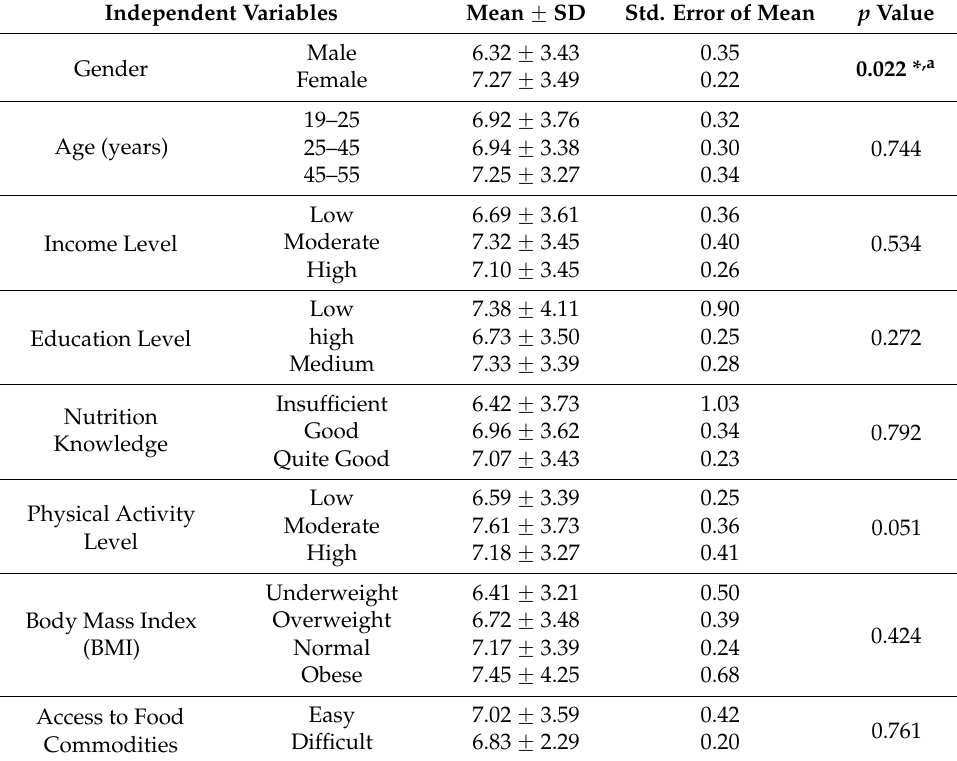
Table 3. Consumption of fruits and vegetables by demographic variables at